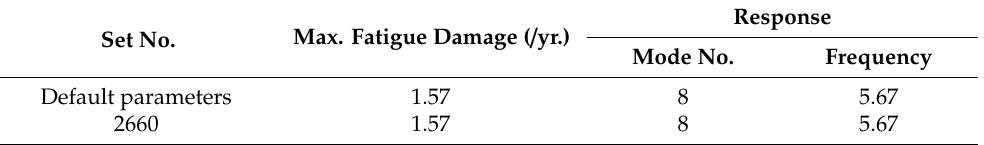
Table 5. Predicted responses for the default set of parameters and parameter with set no. 2660. Set No.